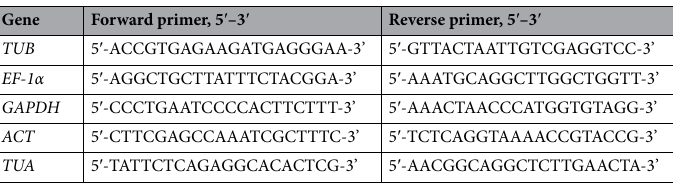
Table 5. Primers used for cloning the reference gene open reading